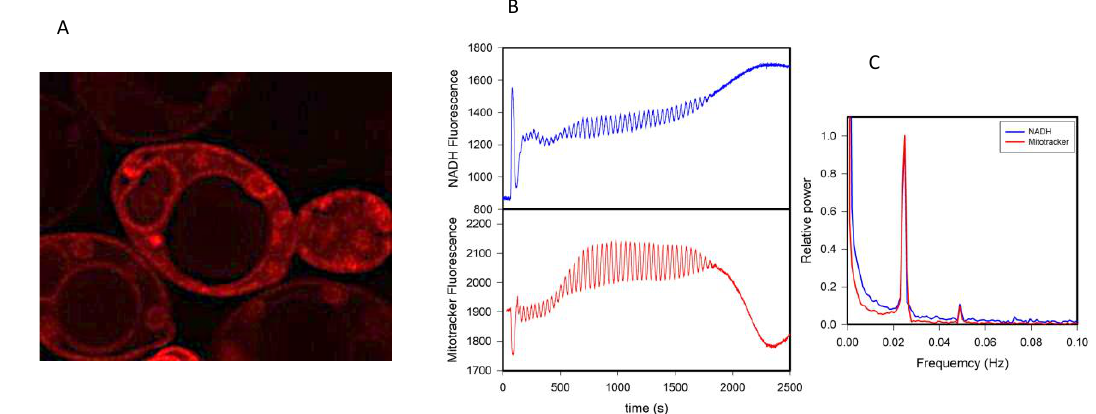
Figure 3. Membrane probes such as Mitotracker red may respond to changes other than membrane potential. ( A ) Fluorescence image of S. cerevisiae BY4743 cells stained with 1 μM Mitotracker red. ( B ) Oscillations in the fluorescence of NADH and Mitotracker red in a suspension of yeast cells where oscillations in glycolysis were induced by the addition of glucose and KCN as seen in Figure 1. ( C ) Power spectra of the oscillations in ( B ). Experimental details can be found in the Materials and Methods